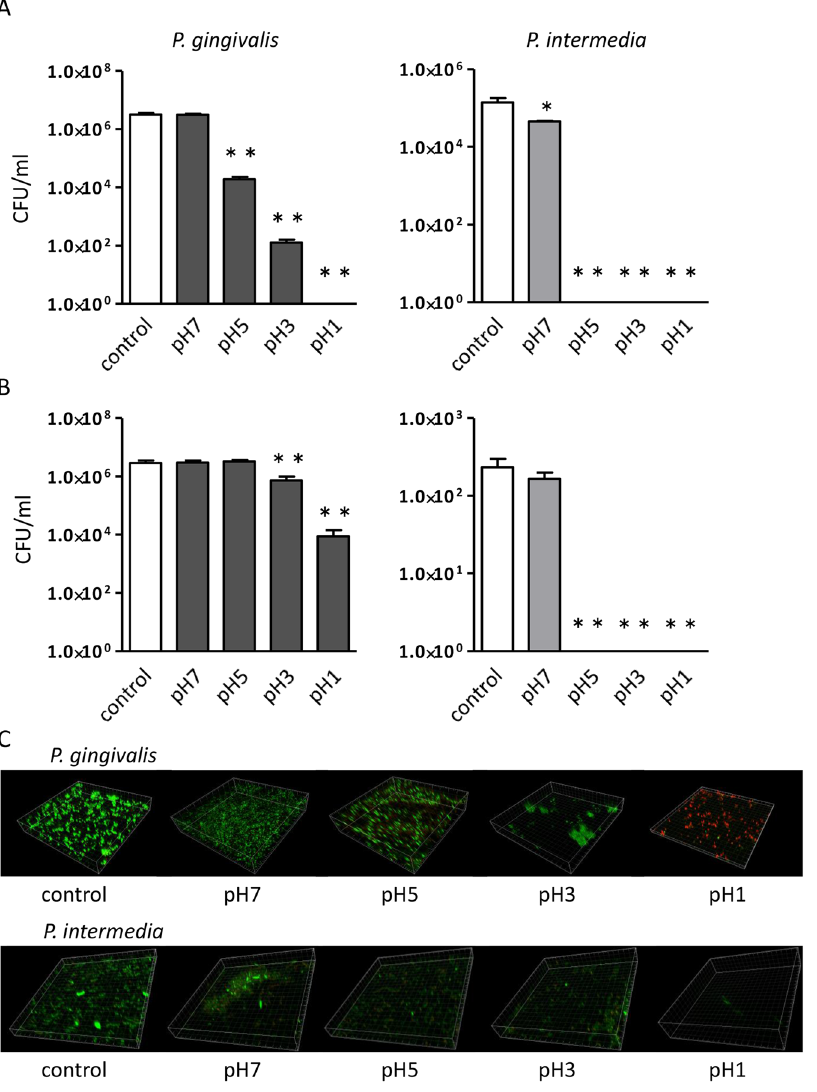
Figure 3. Acid resistance activity of P. gingivalis and P. intermedia cultures. Colony forming unit (CFU)/ml of planktonic cells ( A ) and biofilm ( B ), and confocal laser scanning microscopy images of biofilm ( C ) after 2 h of treatment with PBS or artificial gastric juice with various pH. Data represent the mean ± SEM (N = 4). * p < 0.05, ** p < 0.01, One-way ANOVA with Bonferroni corrections for multiple